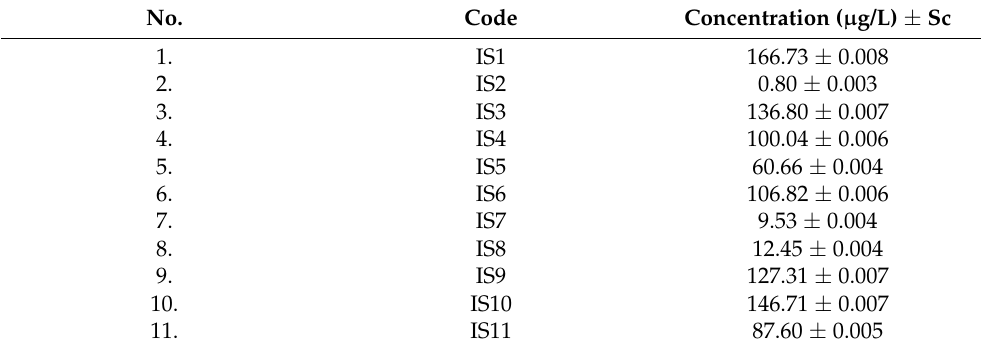
Table 6. Arsenic levels in water